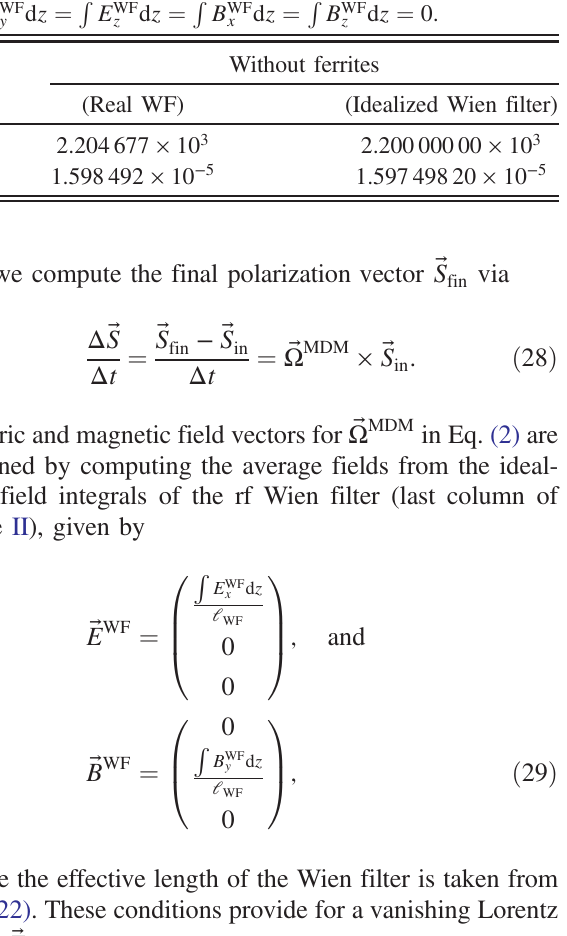
⃗ B WF k ⃗ e . The last column lists the electric and magnetic field integrals of an idealized Wien filter used in the y